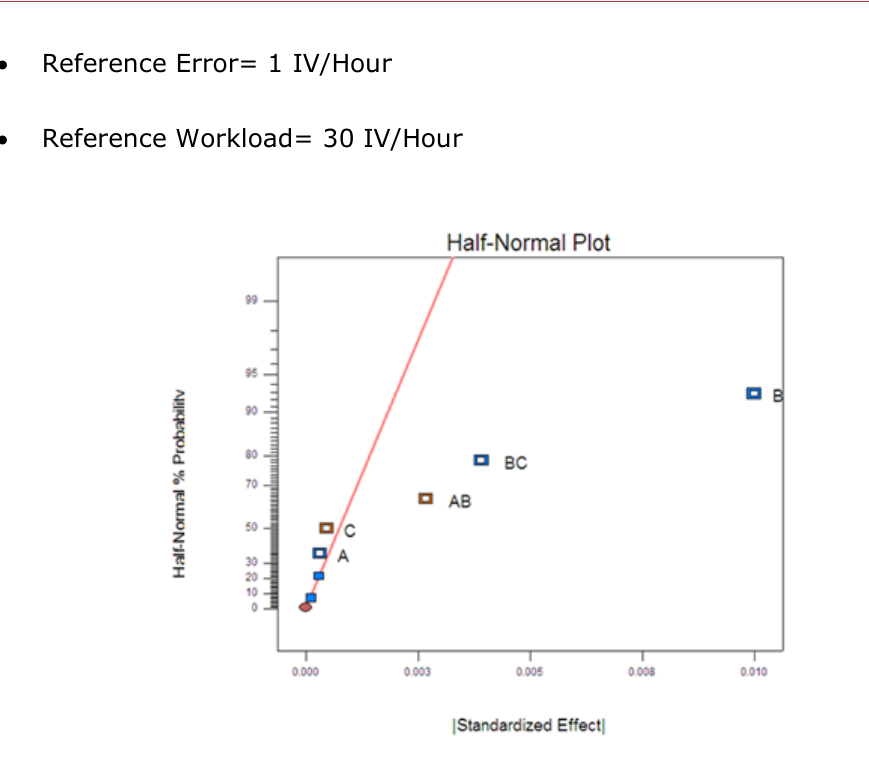
Figure 6. Half-normal probability plot of the medication delivery error effects (model validation)